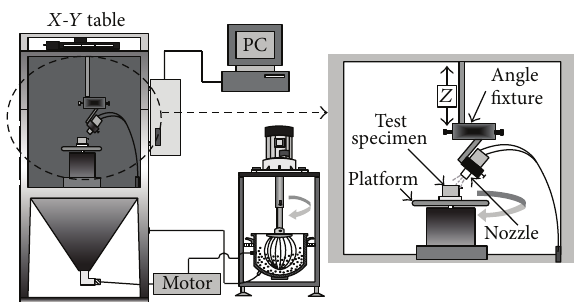
Figure 2: Abrasive jet machining (AJM) system.